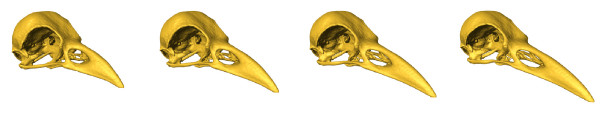
Shape deformations according to the first PLSwhole dimension. The sequence of surface representations (from left to right) as deformations of the average shape correspond to increasing scores of the first PLSwhole dimension in Figure 5. The surface morphs differ from its neighbors by equal multiples of the standard deviation of the actual variability. The first and last column is extrapolated by 4 standard deviations. Major covariation between blocks lies in bill- and cranium-length and in the orientation of the eyes.